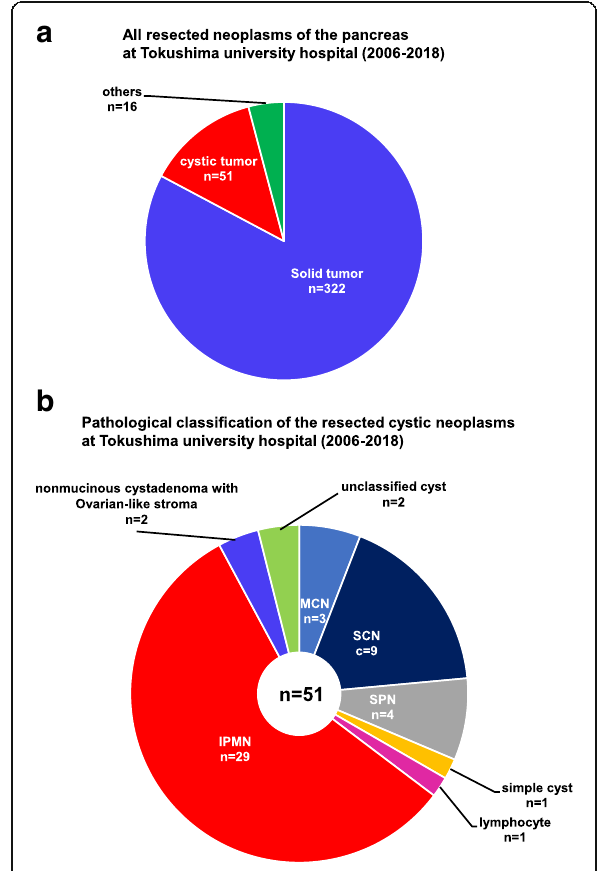
Fig. 1 Ratio of respective tumor patterns in resected tumors of the pancreas at Tokushima University Hospital (2006 –